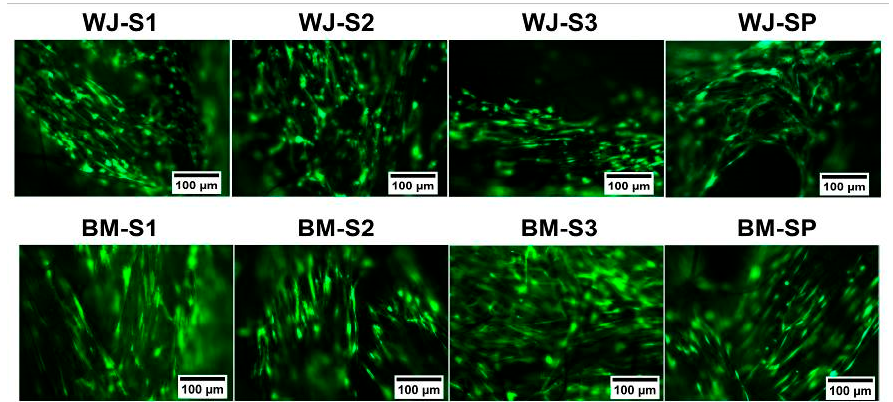
Figure 4. Fluorescent images of live staining of WJ-MSCs (up) and BM-MSCs (down) on the silk and